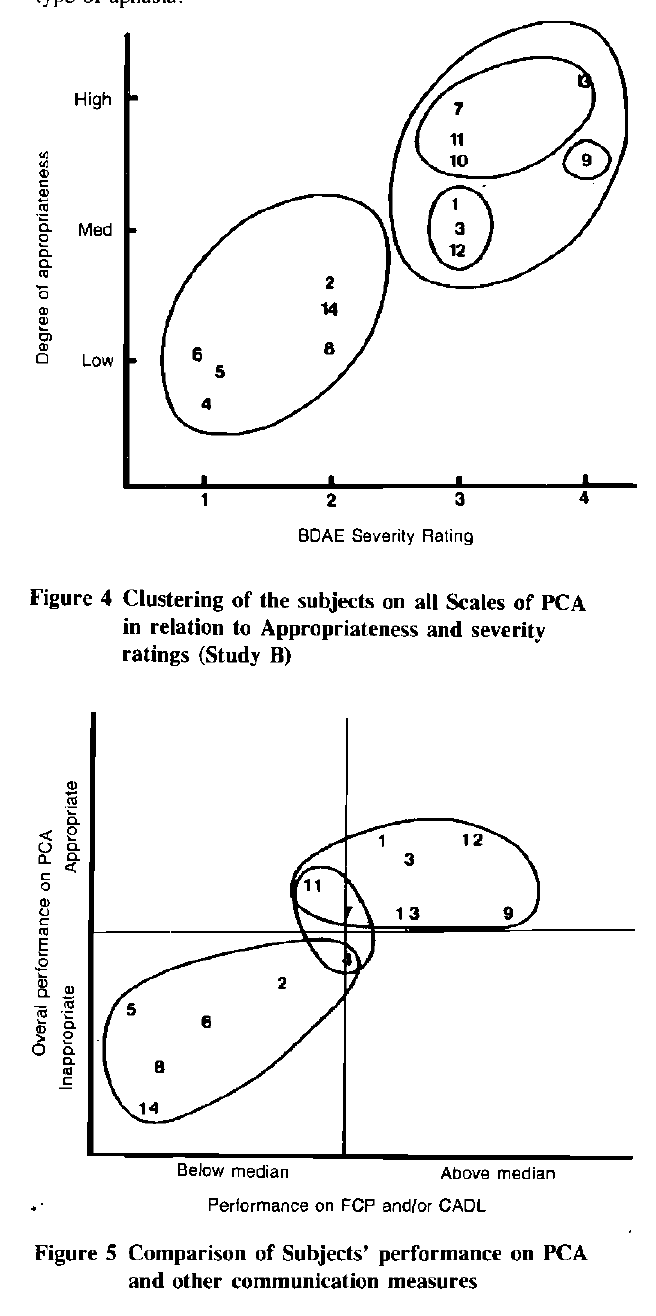
Figure 5 Comparison of Subjects' performance on